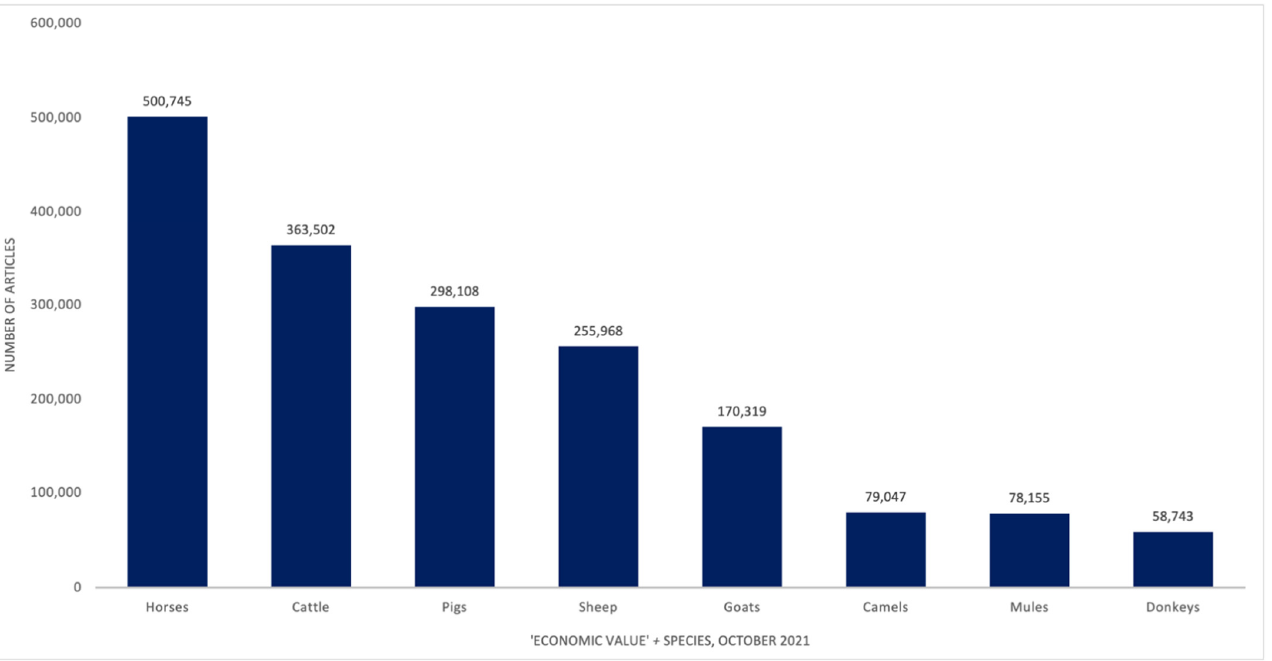
Figure 1. Number of key publication types by the search term “economic value AND species” in the ProQuest database, 11 May 2021. Note: total figure includes scholarly journals, dissertations/theses, books, newspapers, wire feeds, magazines, trade journals and reports.